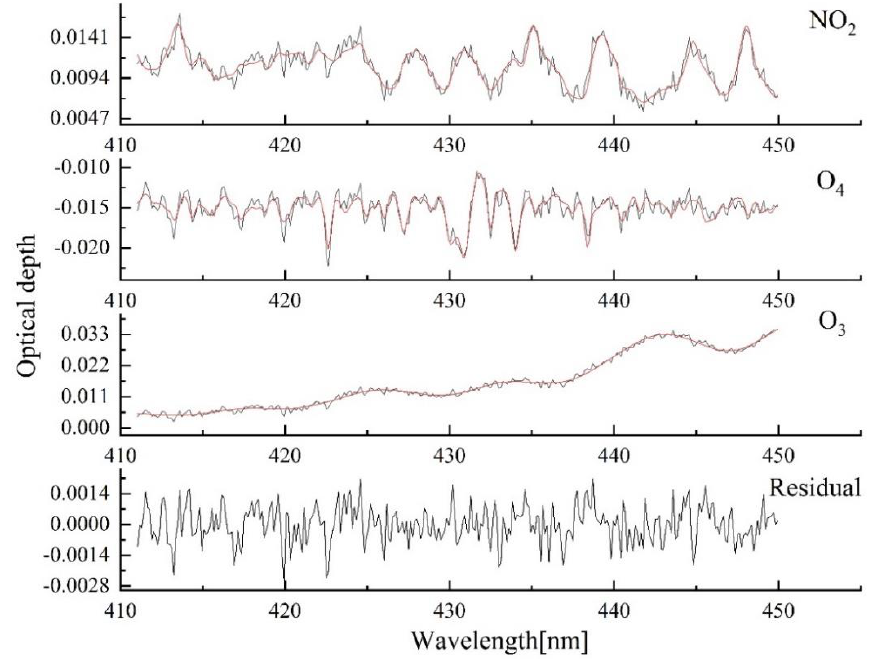
Figure 1. An example of EMI NO 2 retrieved results on 8 January 2019. The NO 2 differential slant column density was 1.97 × 10 16 ± 5.194 × 10 14 molecules cm − 2 ; the red line shows the absorption spectrum of the fitting section of the measurement spectrum (black line).